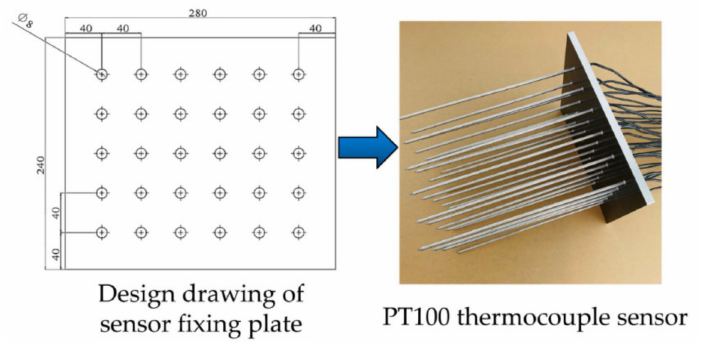
Figure 4. Testo 865 thermal imager.